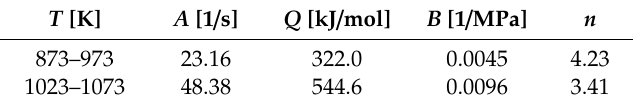
Figure 4. Dependence of the creep rate on applied stress. Solid lines: Garofalo Equation (3), dashed lines: power functions. Table 1. Calculated values of parameters in Equation (3).